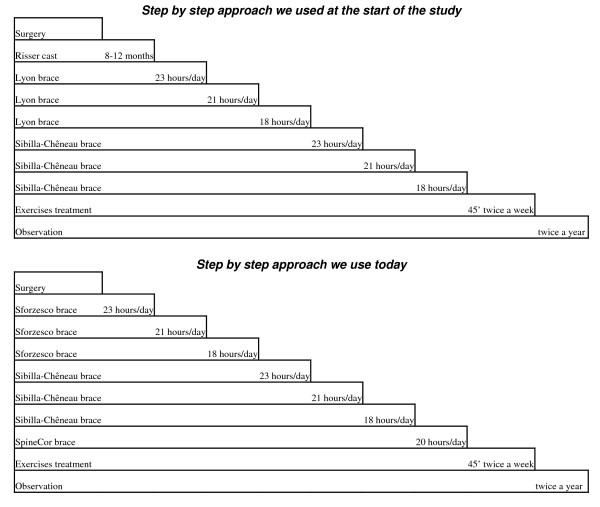
Step-by-step theory. The step-by-step Sibilla theory [13].